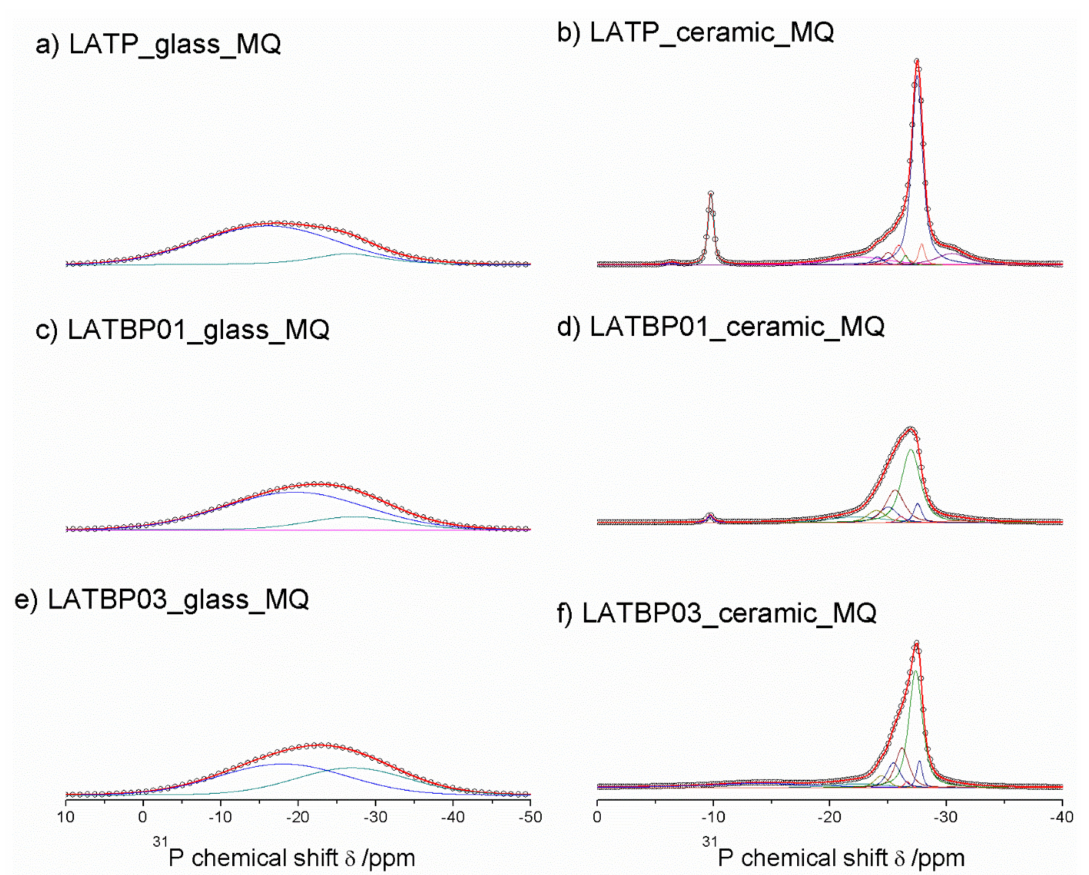
Figure 7. 1D 31 P MAS NMR spectra of the LAT(B)P_MQ series. ( a ) LATP_glass_MQ ( b ) LATP_ceramic_MQ ( c ) LATBP01_glass_MQ ( d ) LATBP01_ceramic_MQ ( e ) LATBP03_glass-MQ ( f )